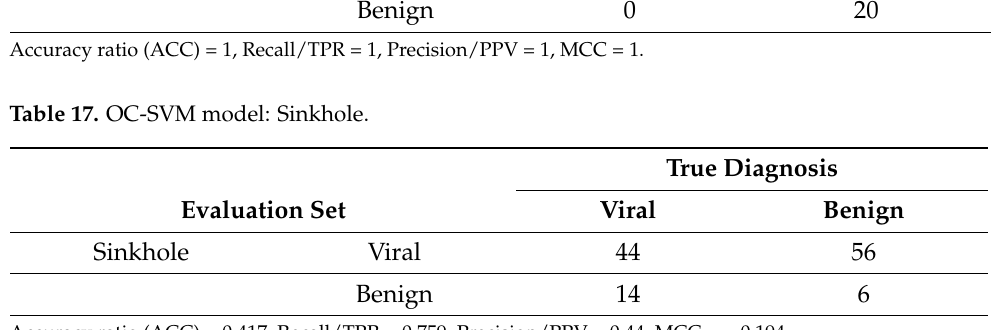
Table 16. C-SVM model: Sinkhole. True Diagnosis Evaluation Set Viral Benign Sinkhole Viral 20 0 Benign 0 20